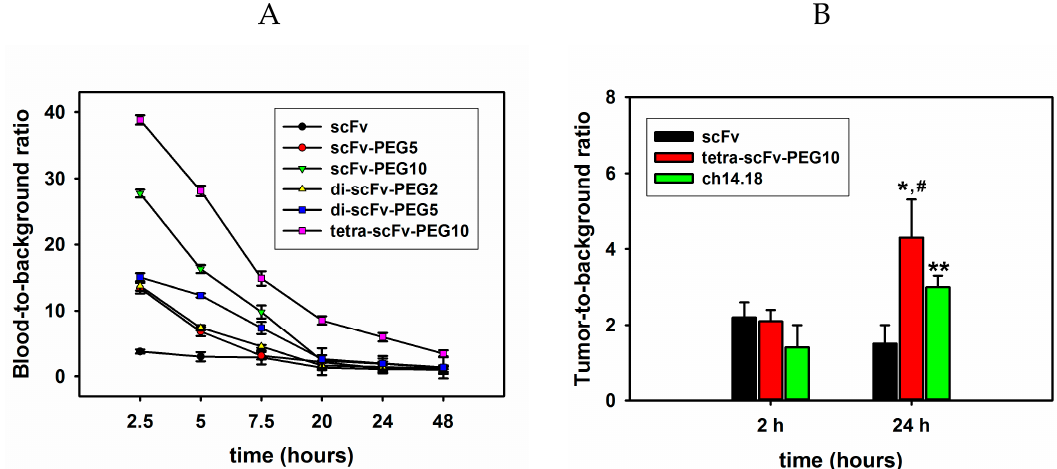
Figure 9. Circulation time and tumor uptake of intact and pegylated scFv fragments after intravenous injection. ( A ) The dynamics of concentration decrease of intravenously administered Cy5-labelled original and modified scFv fragments of GD2-specific antibodies in the blood of mice. ( B ) Accumulation of Cy5-labelled intact scFv, pegylated tetra-scFv fragments, and full-length GD2-specific ch14.18 antibodies in the tumor. Data are represented as mean ± SEM. *—Indicates a value that significantly di ff ers in scFv and tetra-scFv groups at p < 0.05 (Student’s t -test, n = 5), *—Indicates a value that significantly di ff ers in scFv and antibodies groups at p < 0.05 (Student’s t -test, n = 5), #—Indicates a value that significantly di ff ers in tetra-scFv groups and antibodies groups at ± < 0.05 (Student’s t -test, n = 5).